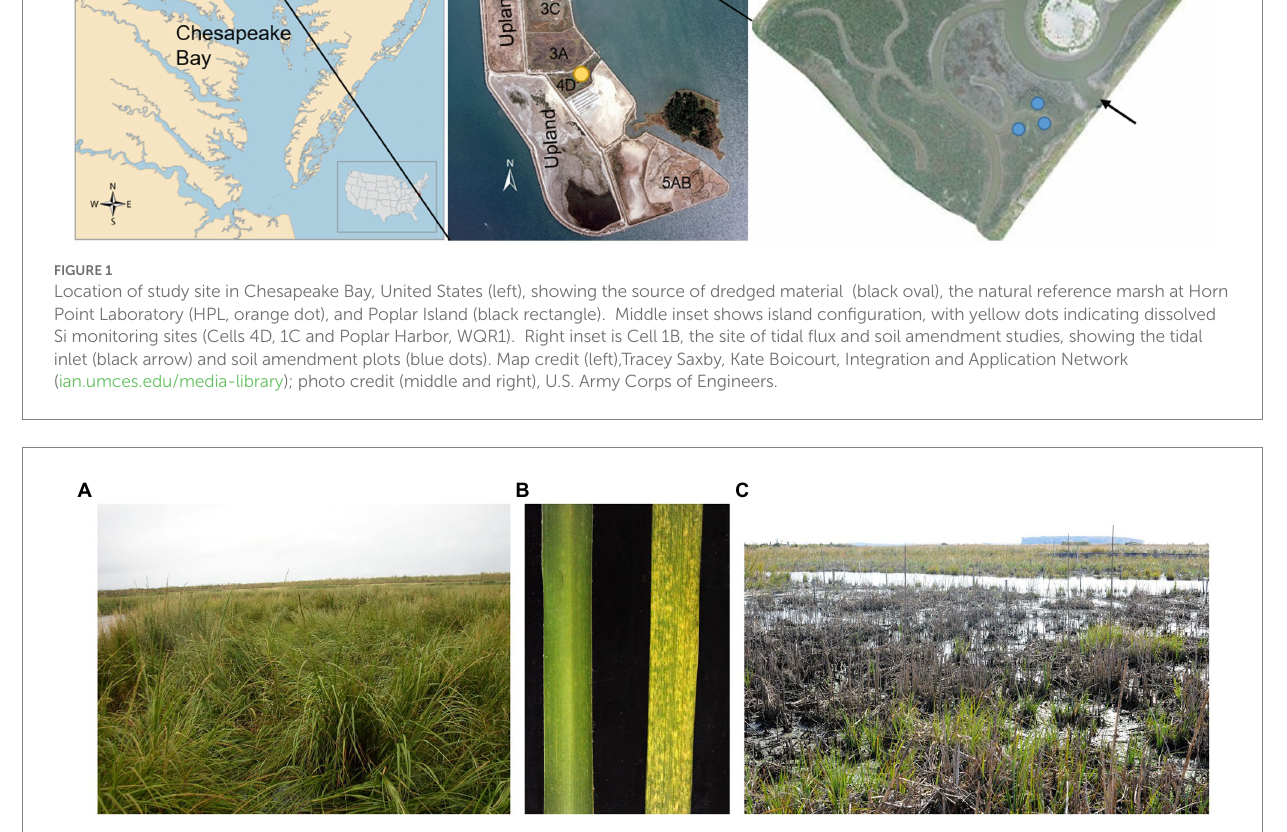
FIGURE 2 Spartina alterniflora characteristics observed at Poplar Island that may be related to nitrogen enrichment include (A) lodging; (B) increased insect pressure (right blade) compared with natural marsh (left blade); and (C) sudden vegetation